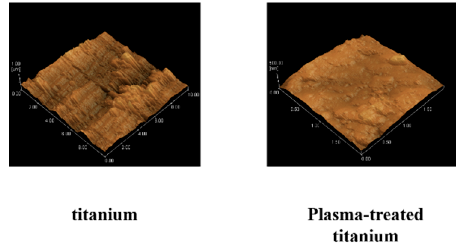
Figure 2. Scanning probe microscopy of titanium and plasma-modified titanium. No changes in surface roughness (titanium; Ra = 7.5, plasma-modified titanium; Ra = 8.2) were detected on the test disks observed by scanning probe microscopy (SPM) (Figure 2).